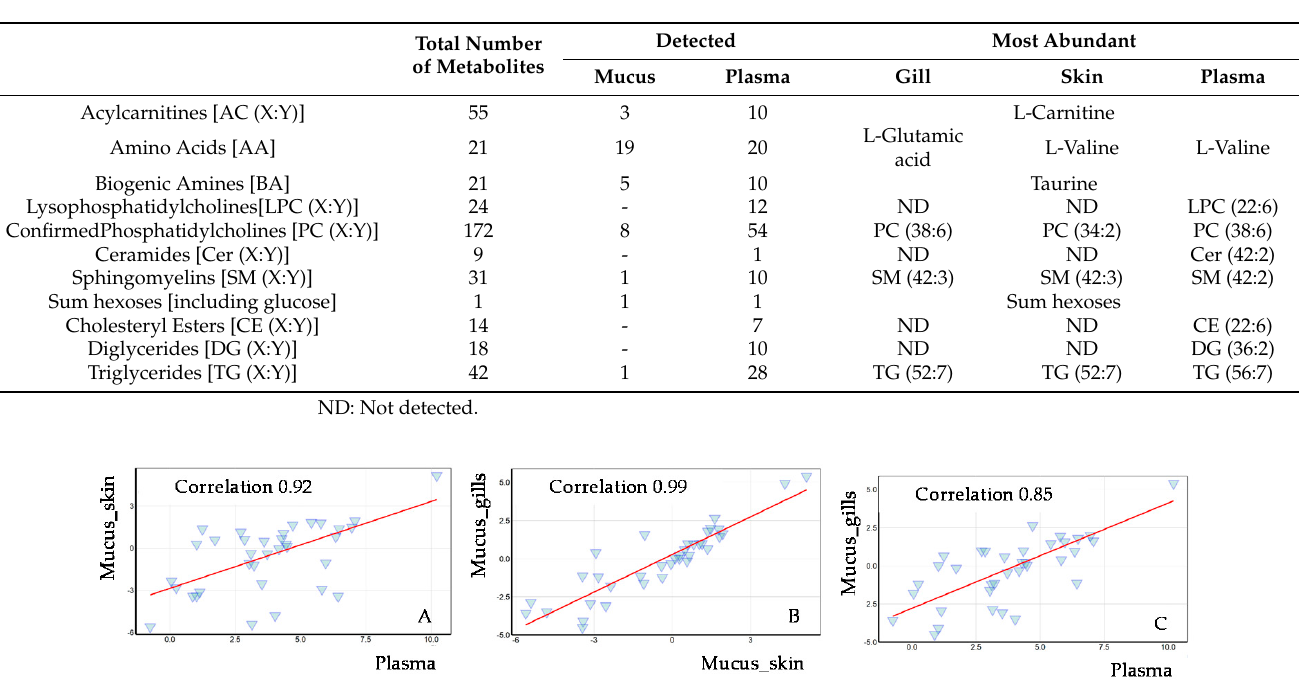
ND: Not detected. Table 4. Number of detected metabolites, organized by compound class, and the most abun- dant metabolite per class in salmon gill, skin mucus and plasma samples detected by using the AbsoluteIDQ ® p400 HR kit.